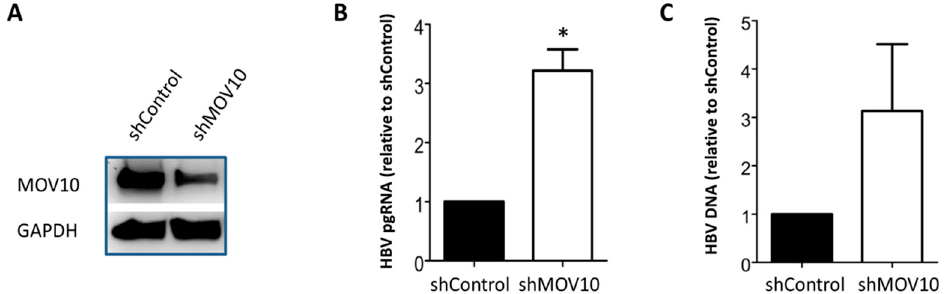
Figure 4. Down-regulation of MOV10 enhances HBV infection of HepG2-sodium taurocholate co-transporting polypeptide (NTCP) cells. HepG2-NTCP-C7 stable cell lines, shControl, and shMOV10, were infected with 250 HBV genome equivalents per cell. Five days later, cells were collected. ( A ) Western blotting showing MOV10 expression in shMOV10 stable cell line compared to shControl. GAPDH was used as a loading control. ( B ) Intracellular HBV pgRNA level determined by RT-qPCR. Data were normalized to GAPDH mRNA expression. ( C ) Intracellular HBV DNA level determined by qPCR. Data represent mean ± standard deviation from at least two independent experiments. * p -value <0.05, two-tailed unpaired t-test.